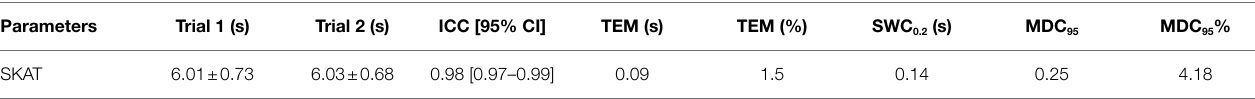
TABLE 1 | Reliability results of